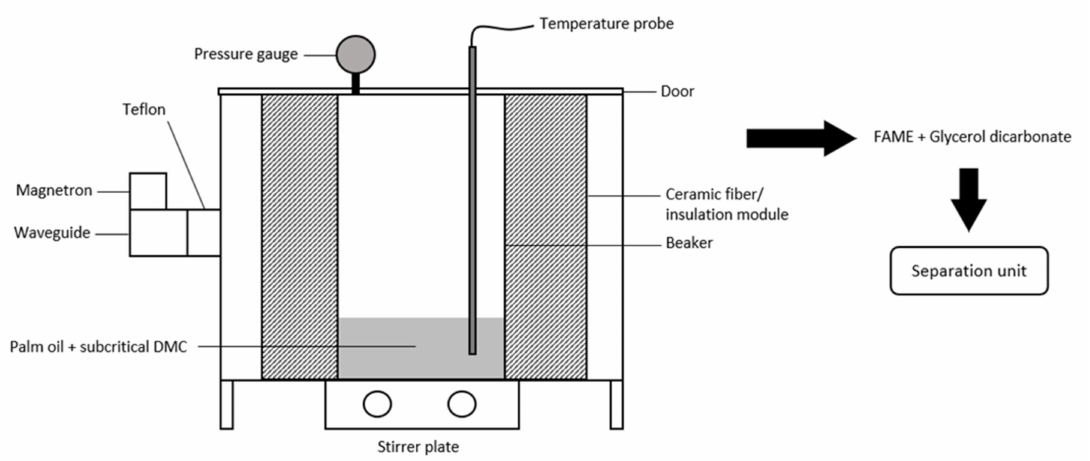
Figure 3. Microwave-assisted transesterification of triglycerides from palm oil with subcritical dimethyl